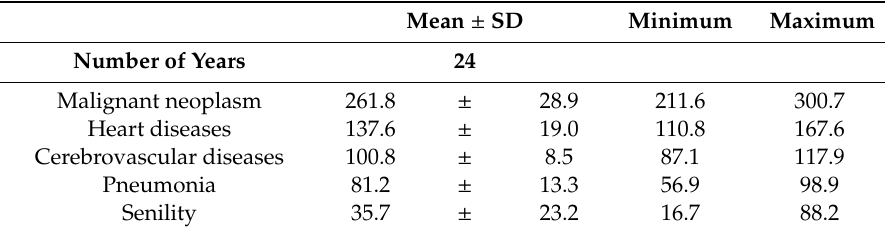
Table 1. Number of deaths stratified by cause among all 47 prefectures in